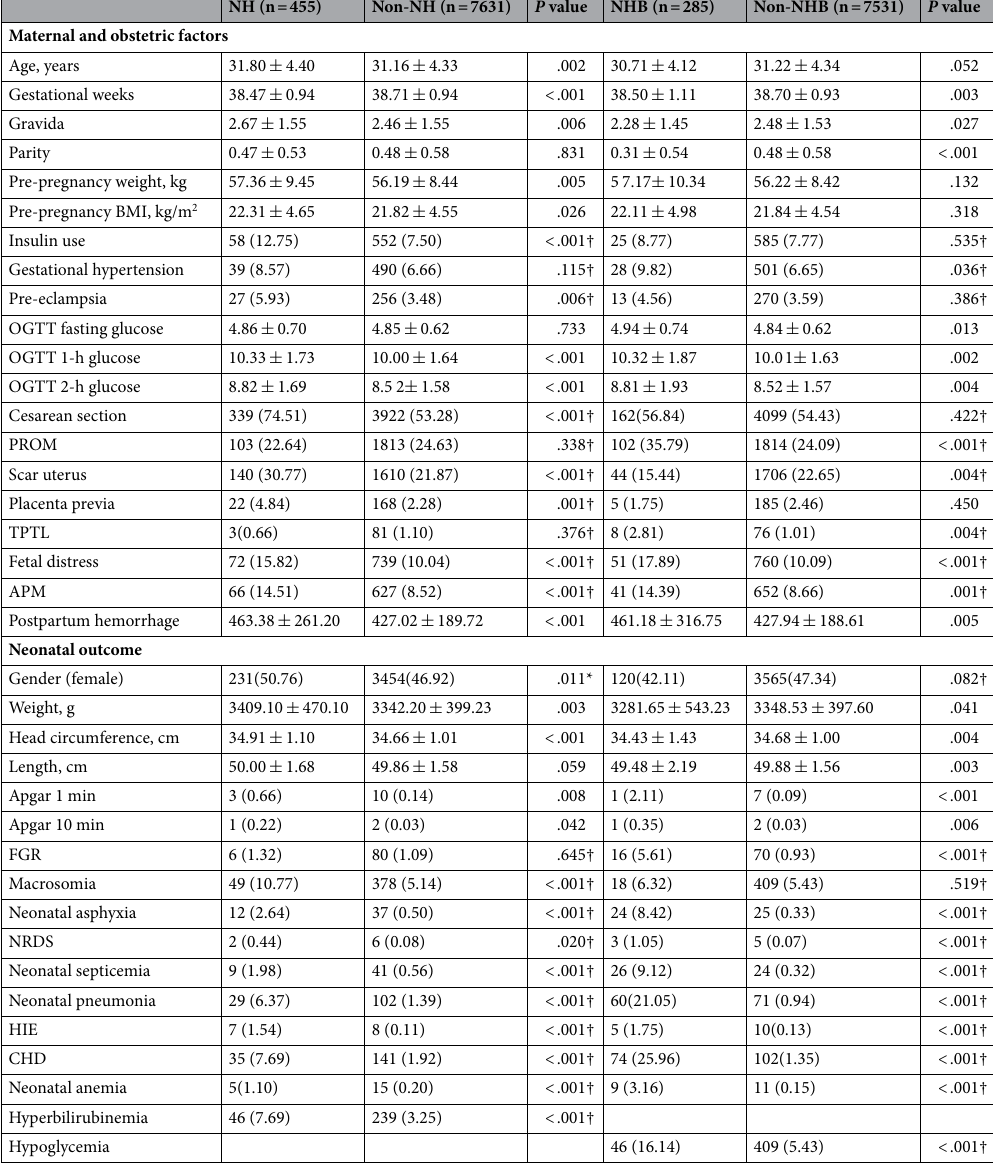
Table 2. Risk factors for neonatal hypoglycemia and hyperbilirubinemia (n = 7816). Values, mean ± SD or n (%). NH neonatal hypoglycaemia, NHB neonatal hyperbilirubinemia, GWG gestational weight gain, BMI body mass index, ICP intrahepatic cholestasis of pregnancy, OGTT oral glucose tolerance test, PROM premature rupture of membranes, TPTL threatened premature labor, FGR fetal growth restriction, NRDS, neonatal respiratory distress syndrome, HIE hypoxic ischemic encephalopathy, CHD congenital heart disease, APM abnormal placental morphology. †